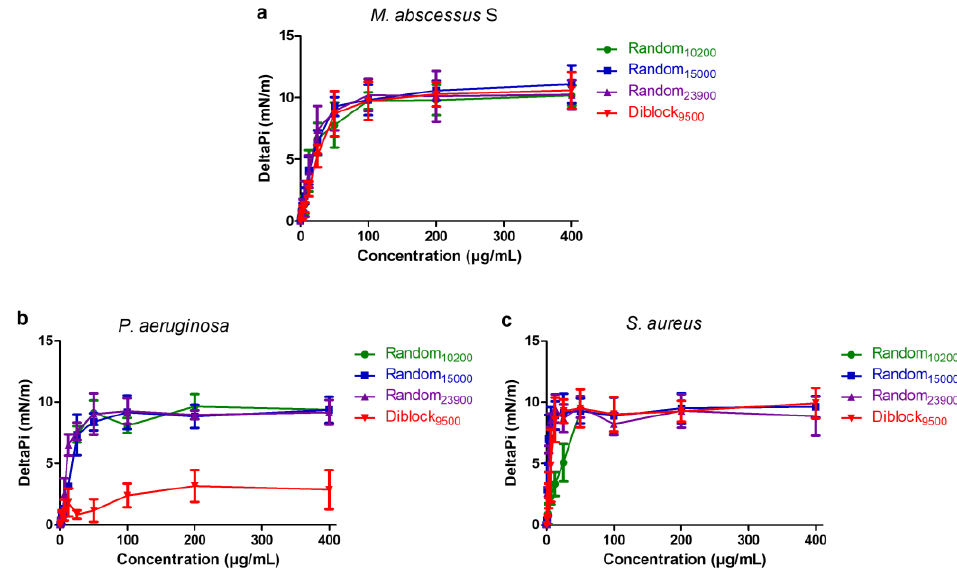
Figure 6. Evaluation of the insertion of the copolymers in lipid monolayers. The insertion of the copolymers in lipid monolayers from M. abscessus S ( a ), P. aeruginosa ( b ), and S. aureus ( c ) was evaluated by measuring the surface pressure (deltaPi) as a function of copolymer concentration. Mean ± SD of deltaPi (mN/m) is represented (n = 3).